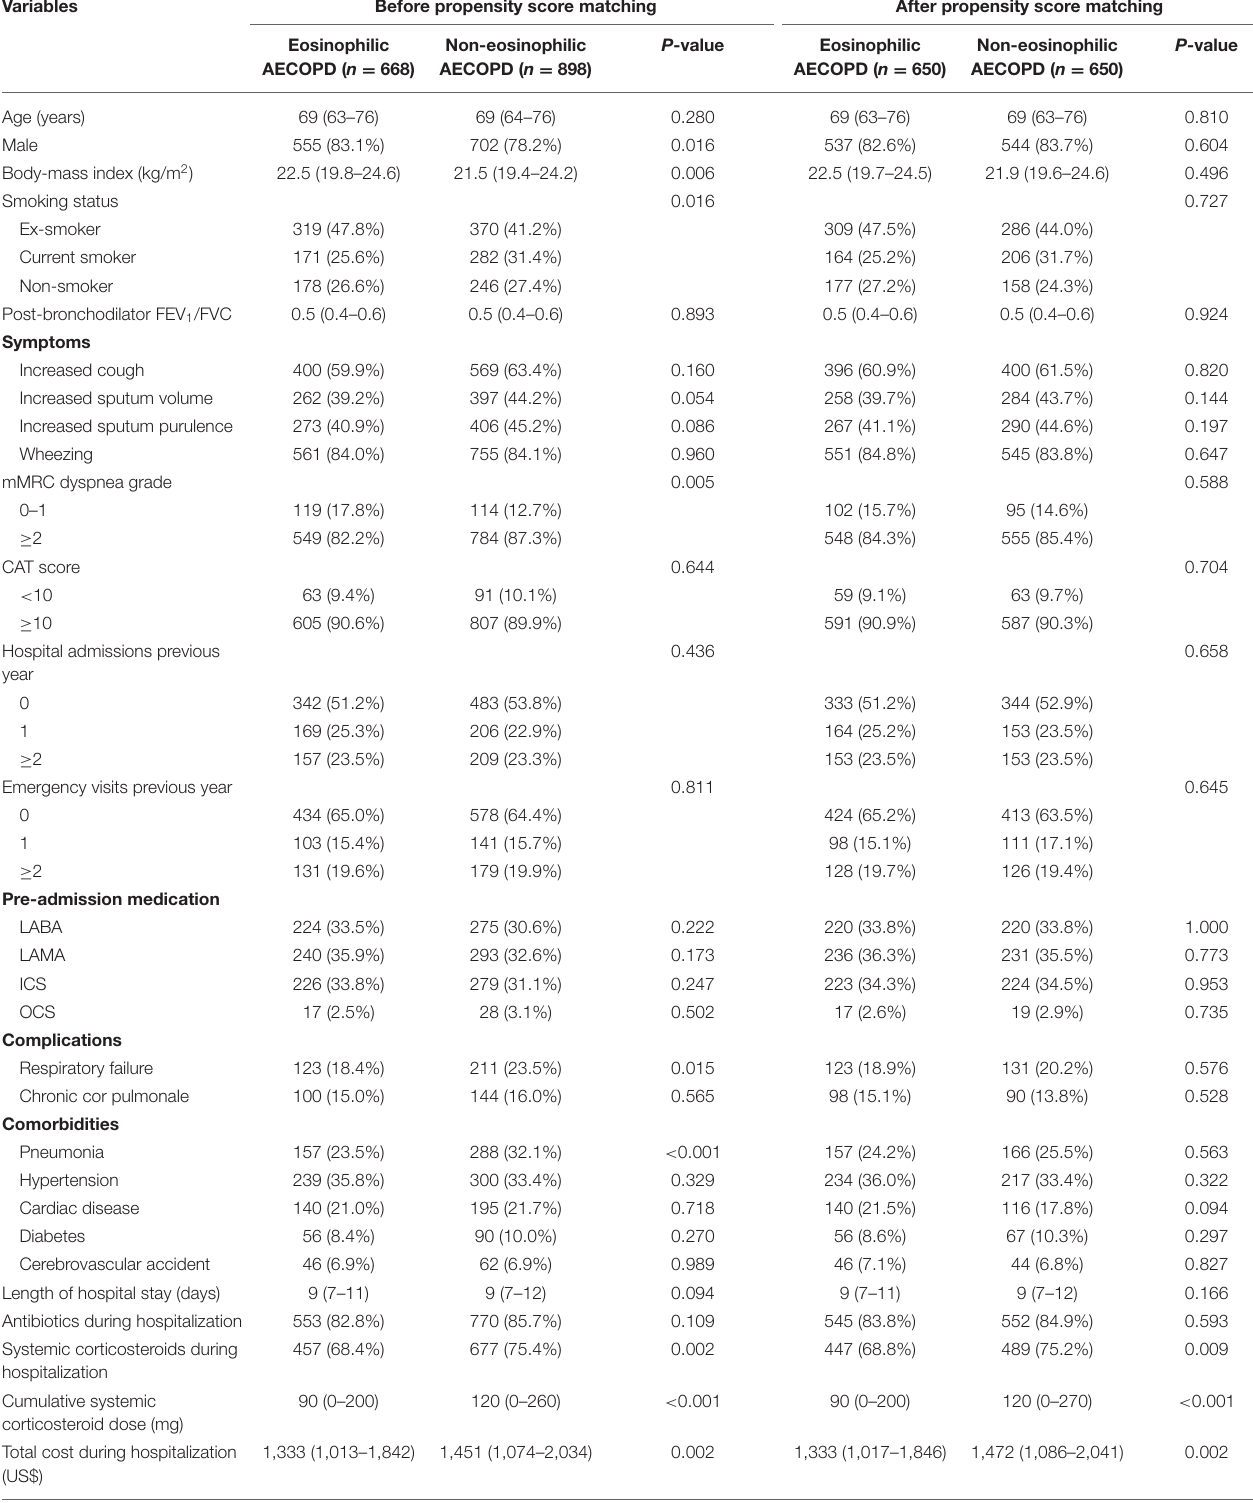
TABLE 1 | Clinical characteristics of the study patients before and after propensity score matching.